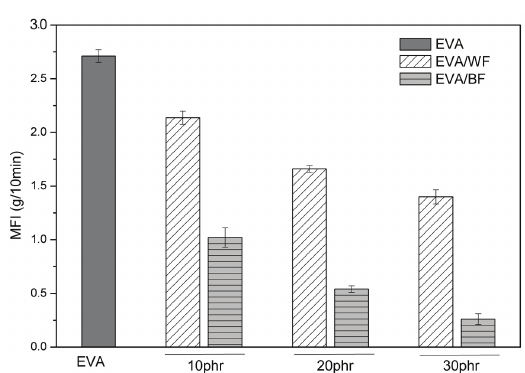
Figure 5. MFI for EVA, EVA/WF and EVA/BF